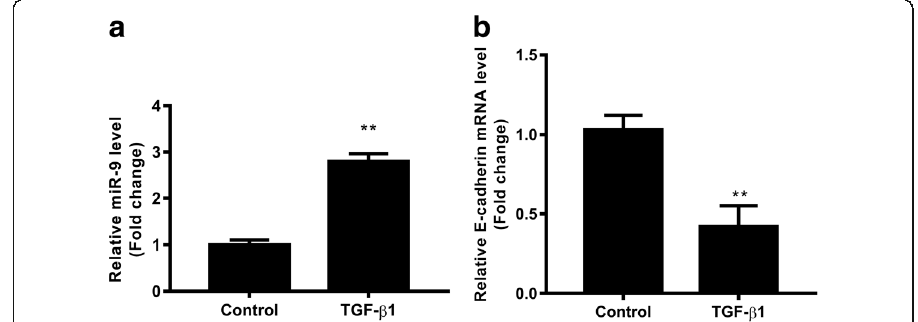
Fig. 3 TGF- β 1 promotes the expression of miR-9 and inhibits the expression of E-cadherin mRNA. After treatment with TGF- β 1 (5 ng/ml) for 24 h, the expressions of miR-9 ( a ) and E-cadherin mRNA ( b ) in A549